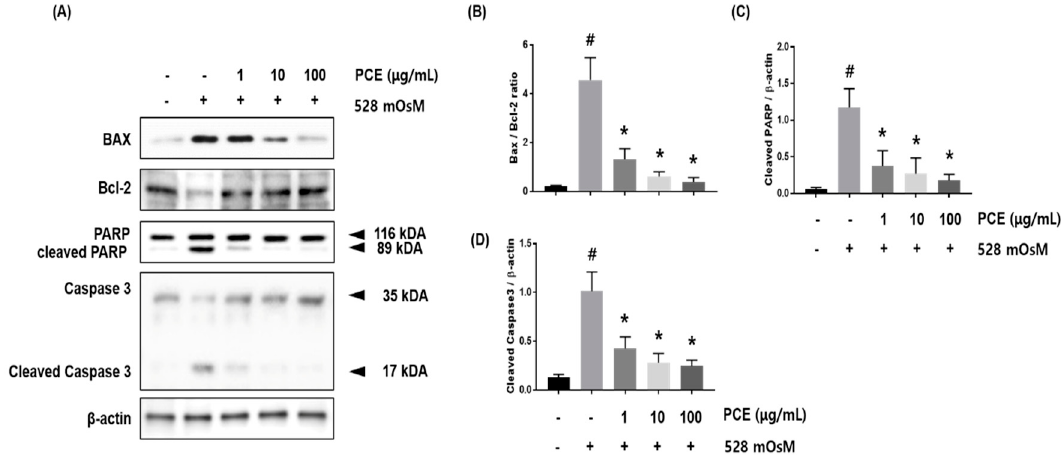
Figure 7. Effects of P. cuspidatum (PCE) on hyperosmolar stress-induced apoptotic cell death in human corneal epithelial cells (HCECs). HCECs were co-treated with the indicated concentrations of PCE